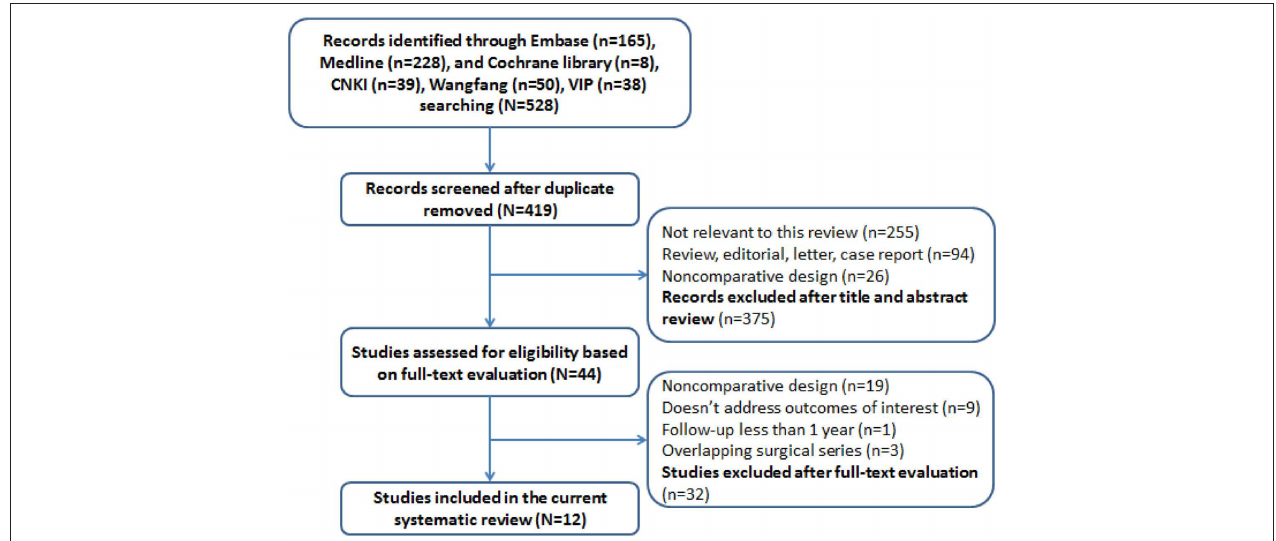
FIGURE 1 | Flow diagram of study selection in the